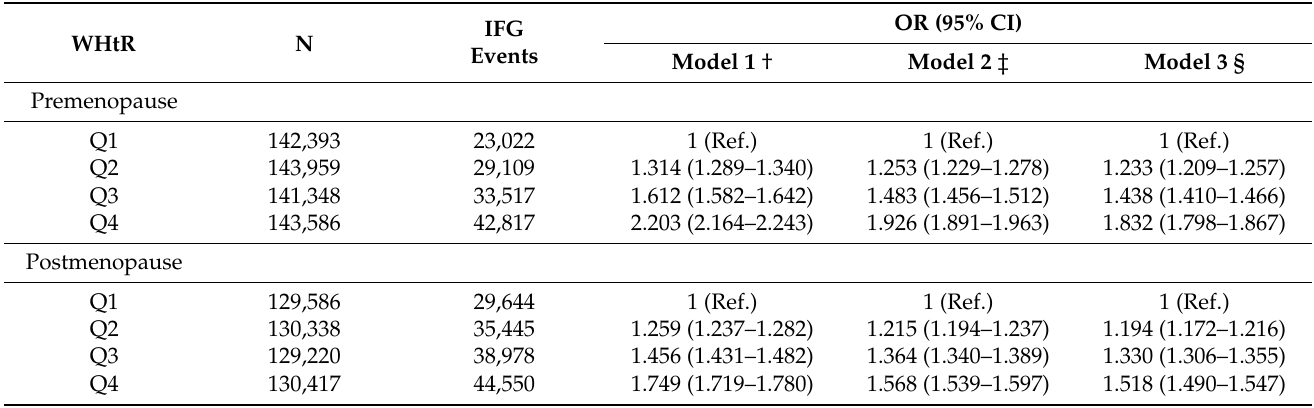
Table 3. Multivariate logistic regression analysis of the association between impaired fasting glucose events and waist-to-height ratio according to menopausal